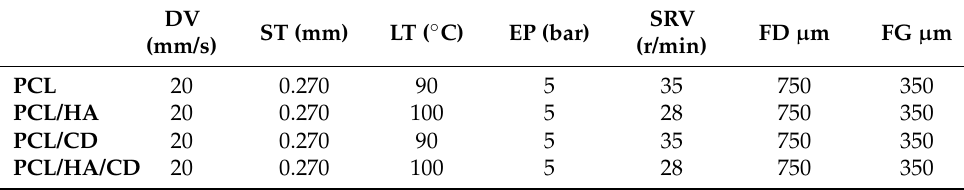
Table 1. Process/instrument parameters used to print PCL, PCL/HA, PCL/CD and PCL/HA/CD scaffolds. Deposition velocity (DV), slice thickness (ST), liquefier temperature (LT), extrusion pressure (EP), screw rotation velocity (SRV), (FD) filament distance and (FG) filament gap.